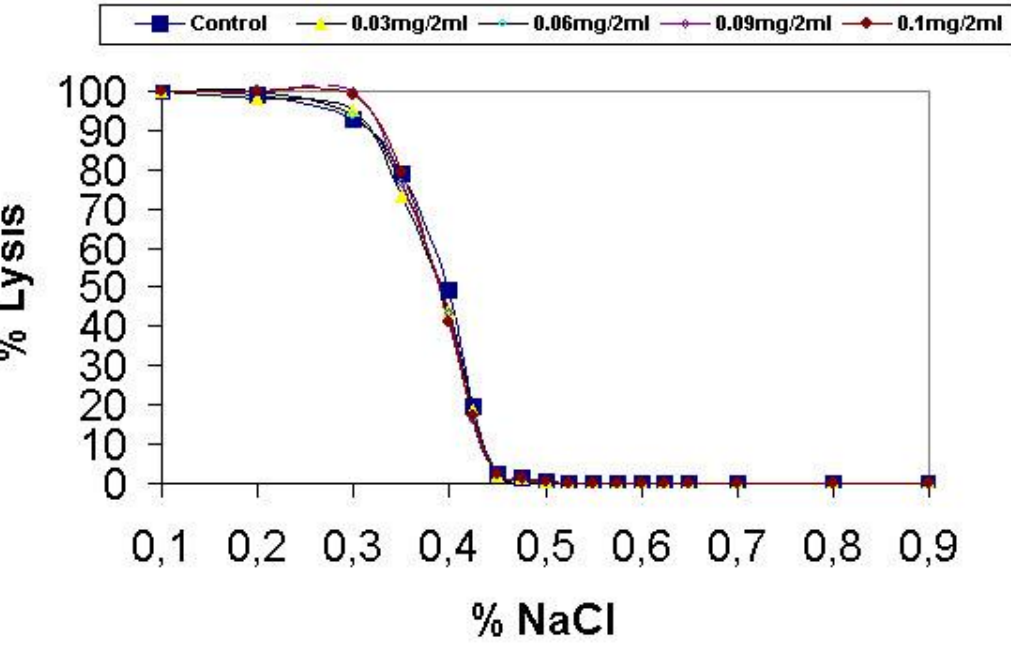
Figure 3: In vitro effect of O. doriae venom (0.03, 0.06, 0.09, and 0.1 mg / 2 ml of blood) on the osmotic fragility of RBCs after incubation for 30 minutes.